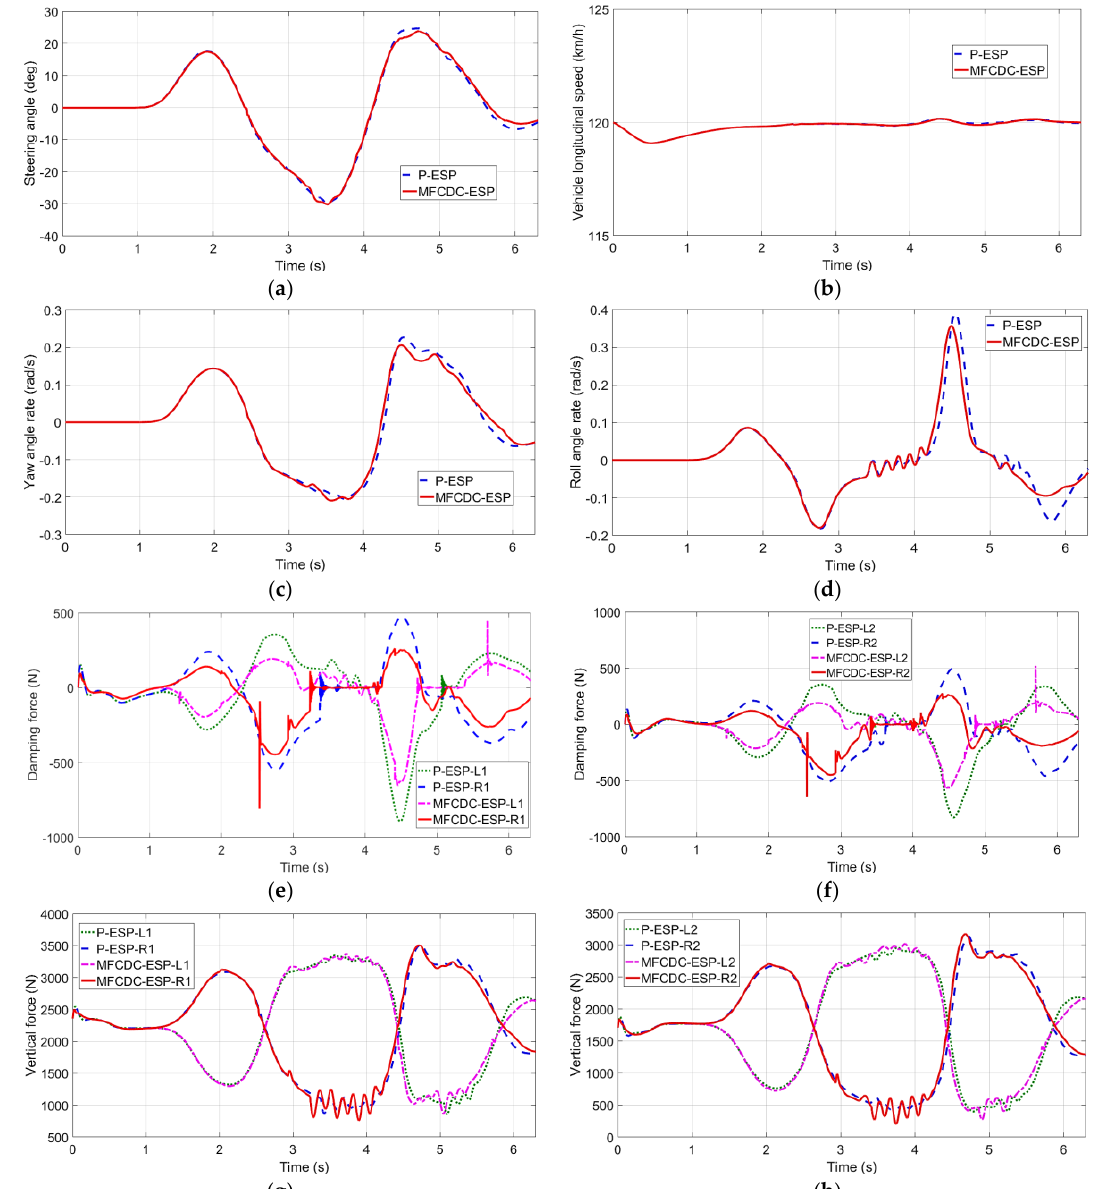
Figure 11. Simulation results of DLC test. ( a – d ) are the comparison results of the steering angle, vehicle longitudinal speed, yaw angle rate, and roll angle rate, respectively. The damping forces and vertical forces of each wheel of the DLC test with P-ESP and MFCDC-ESP. ( e ) is the comparison of the damping forces of the front wheels. ( f ) is the comparison of the damping forces of the rear wheels. ( g ) is the comparison of the vertical forces of the front wheels. ( h ) is the comparison of the vertical forces of the rear wheels. The details are available in the legend. L denotes left, R denotes right, 1 denotes the front axle, and 2 denotes the rear